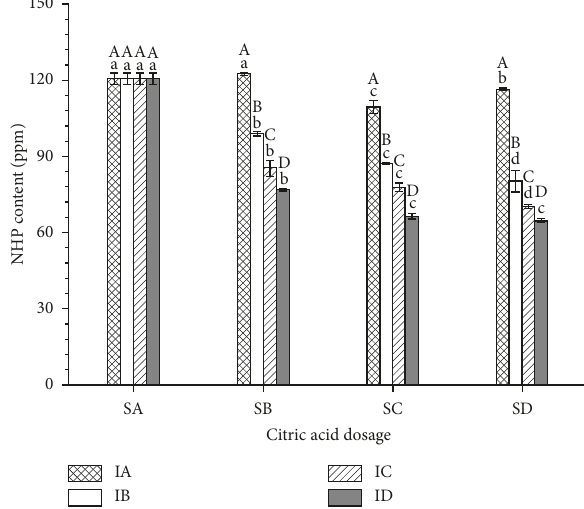
Figure 1: Effect of citric acid dosage and mixing conditions on NHP content. Note . SA: dewaxed rice bran oil without addition of citric acid; SB: dewaxed rice bran oil with 0.065% citric acid added; SC: dewaxed rice bran oil with 0.10% citric acid added; SD: dewaxed rice bran oil with 0.13% citric acid added; IA: high shear mixer of 10000 rpm for 30 sec after 30 min of incubation; IB: high shear mixer of 10000 rpm for 30 sec after 60 min of incubation; IC: high shear mixer of 20000 rpm for 30 sec after 60 min of incubation; ID: high shear mixer of 23000 rpm for 30 sec after 60 min of incubation. Uppercase superscripts represent significant differences between groups; lowercase superscripts represent significant differences within a group ( P <